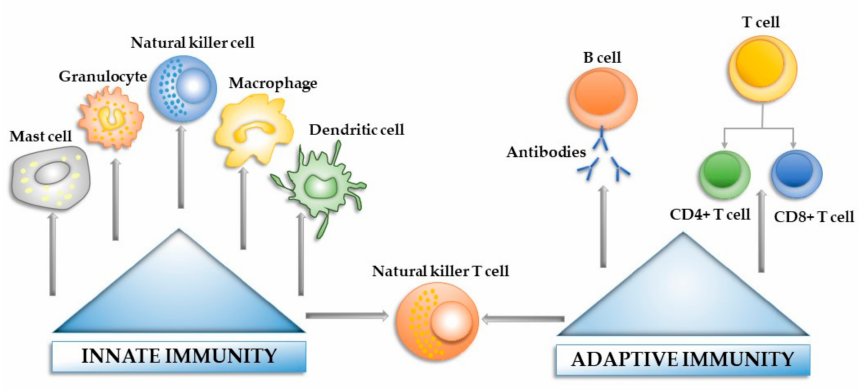
Figure 1. The main components of the innate and adaptive immune